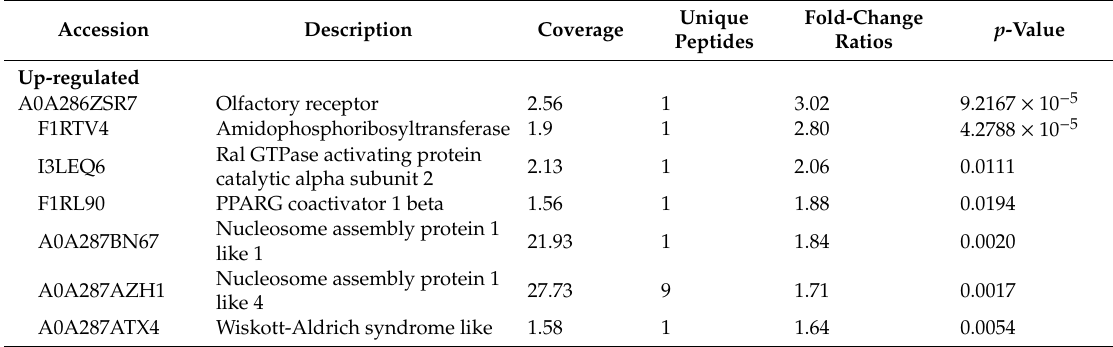
Figure 2. Volcano plot and the hierarchical clustering involved in the differentially expressed proteins (DEPs). ( A ) Volcano plot showed the levels of DEPs detected in mock-treated or PSV-infected groups. X axis, mean log 2 (ratio of fold change); y axis, log 10 ( p -value); red balls, DEPs between the two groups ( p < 0.05 and ratio > 2 or < 0.5). ( B ) Hierarchical cluster of 181 DEPs with 1.2-fold up-regulation and 0.85-fold down-regulation. The proteins were classified into two categories with opposite directional variation, suggesting the screening rationality of DEPs. Different color indicated different fold change. Red: Highly expressed, blue: Lowly expressed, and white: No change. Table 1. The significantly up-regulated and down-regulated di ff erentially expressed proteins (top 20) in PK-15 cells infected with Sapelovirus